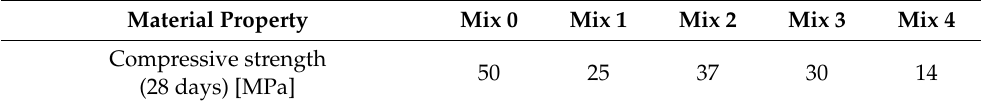
Table 4. Properties of the different material mixes.